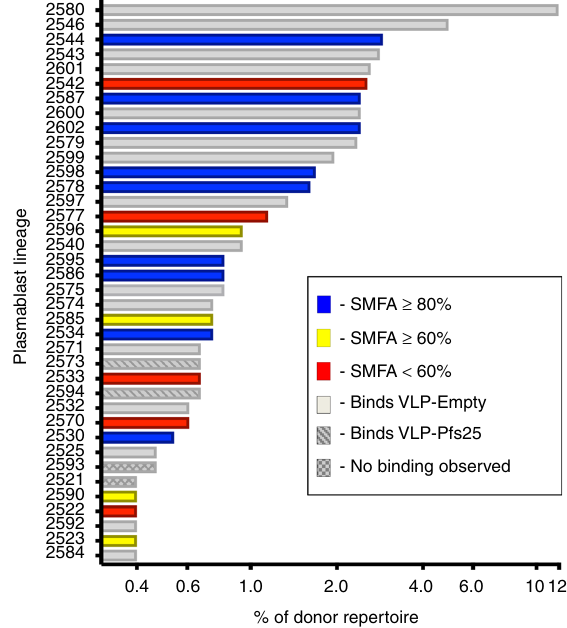
Fig. 1 Plasmablast responses of a human donor to Pfs25-VLP immunization. Rows correspond to different antibody lineages. Labels on the left correspond to a representative lineage member that was puri fi ed, expressed, and tested for binding activity by ELISA with Pfs25 monomer, Pfs25-VLP (Pfs25 + VLP) or VLP-empty (VLP alone with no antigen). VLP- empty refers to only the virus-like particle that displays the antigen, as previously described 31 . Antibodies that bound to the Pfs25 monomer were further tested by SMFA at 100 µ